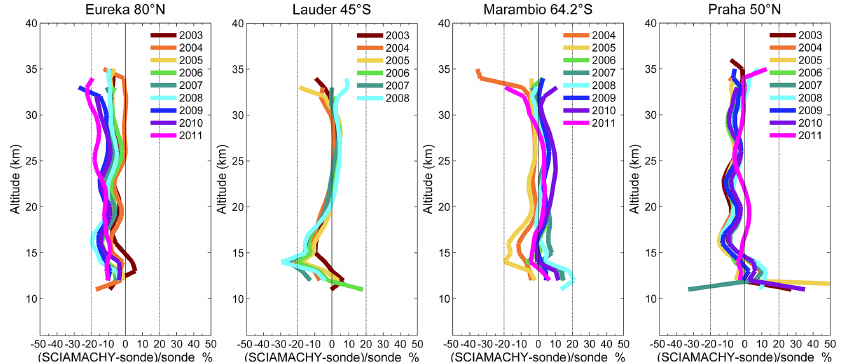
Figure 4. V2.9 yearly vertical profile comparisons of the relative differences between SCIAMACHY and ozonesondes at Eureka, Lauder, Marambio and Praha.